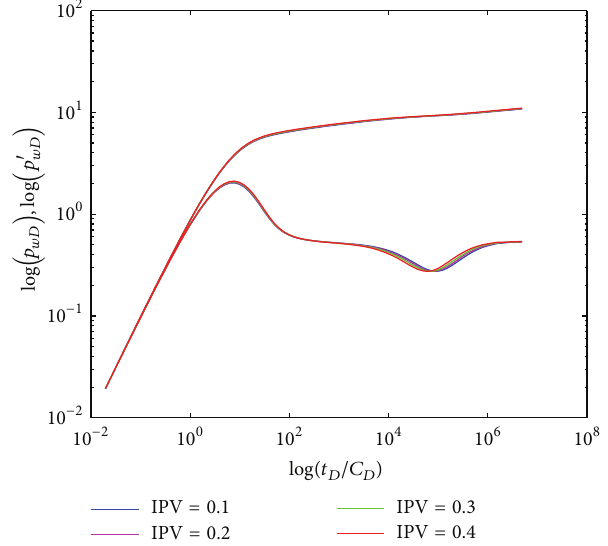
Figure 9: Effect of IPV on type